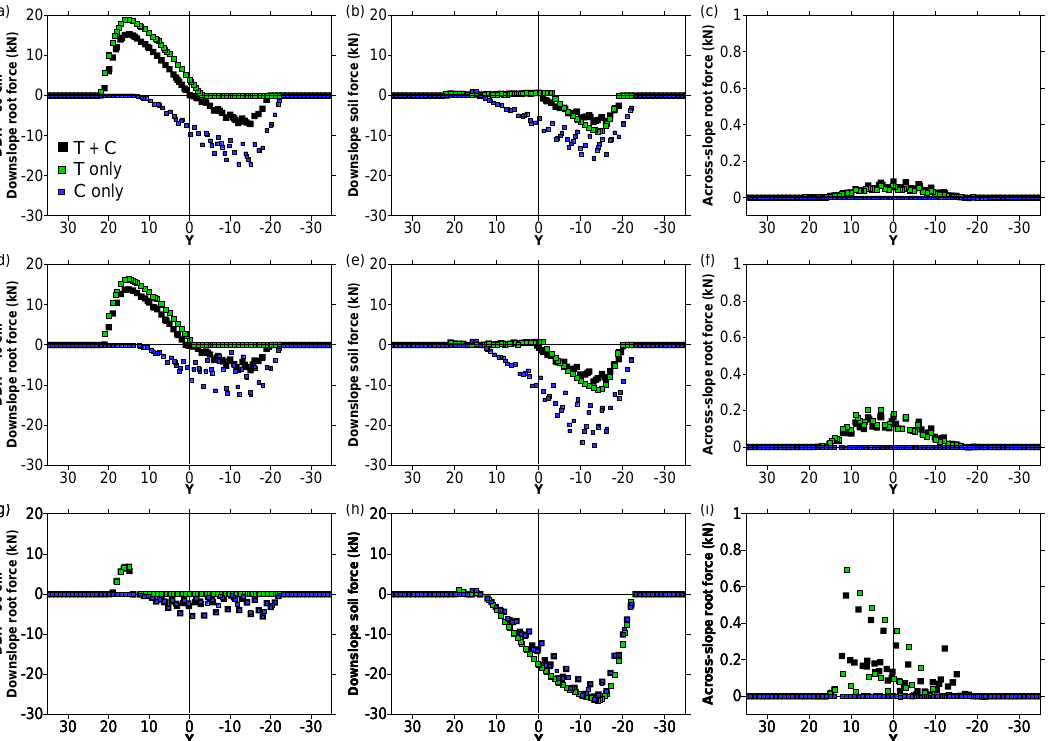
Figure 11. Effects of tensile ( T ) and compressive ( C ) strength of roots on root and soil bond force distribution along a downslope section at the centerline ( x = 0) along a row of trees for a tree-covered slope with (a–c) DBH = 50cm, (d–f) DBH = 40cm, and (g–i) DBH = 30cm. (a, d, g) Downslope root force. (b, e, h) Downslope soil force. (c, f, i) Across-slope root force. Sections are shown either at the end of the run for simulations that did not fail or at the time step just prior to failure for those that did (see Fig. 10).